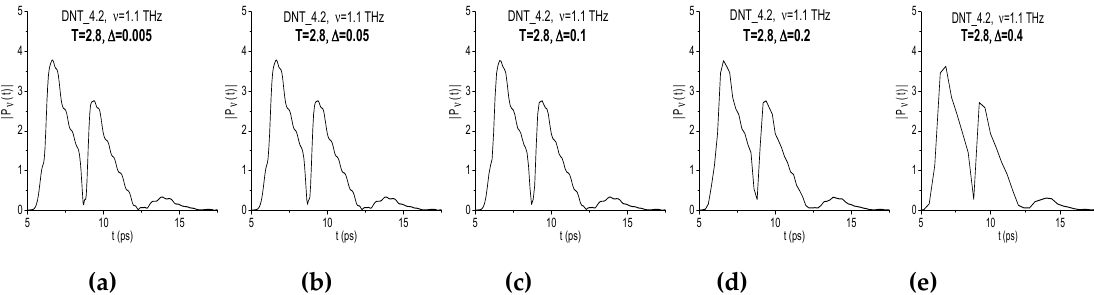
Figure A2. The spectral line dynamics at the frequency ν = 1.1 THz computed at the window length T = 2.8 ps and the window shift ∆ = 0.005 ( a ), 0.05 ( b ), 0.1 ( c ), 0.2 ( d ), 0.4 ( e ) ps.